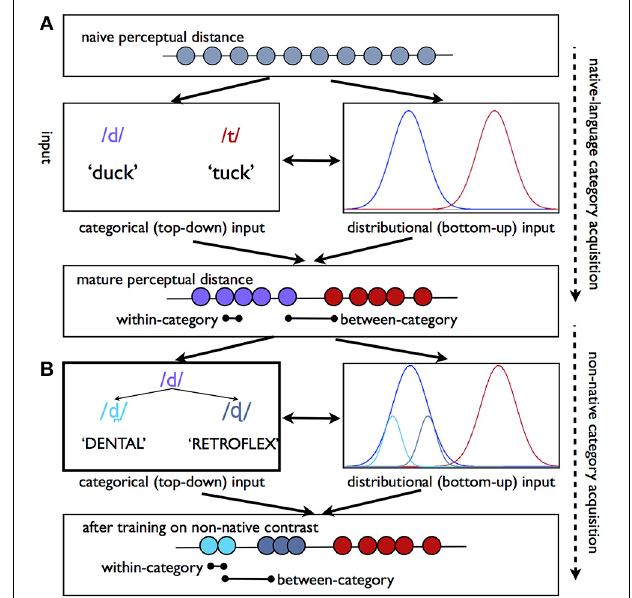
FIGURE 1 | Perceptual warping as a consequence of phonetic category learning. (A) Schematic of the process by which categorical perception emerges through development. Top line reflects the naïve perceptual distance between tokens along an arbitrary acoustic-phonetic continuum. Over the course of development categorical information (e.g., the use of tokens to refer to minimal pairs) and the statistical distribution of tokens in acoustic-phonetic space (e.g., more tokens are heard that fall near the center of the phonetic category) converge to warp perceptual sensitivities such that between-category contrasts are more perceptually distinct than within-category contrasts. (B) Non-native speech sound training paradigms primarily rely on categorical-level cues (e.g., explicit feedback), to reshape existing sensitivities. In this particular example, a listener must learn that two non-native sounds which are typically perceived as variants of /d/ correspond to different categories. This type of learning situation presents a particular challenge to the adult learner, given that the perceptual distance between these tokens in the mature listener is collapsed. Learning may proceed either via the top-down route, (left), or via passive exposure to statistical regularities in the input (right), or both. Over time, this information likewise results in differences for within- vs. between-category